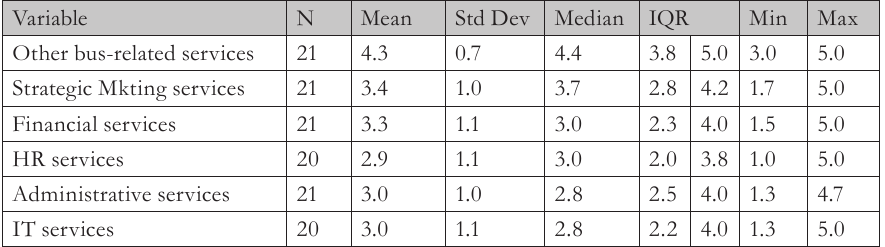
Tab. 4 – Median Scores of Composite Variables for Business Support Services. Source: